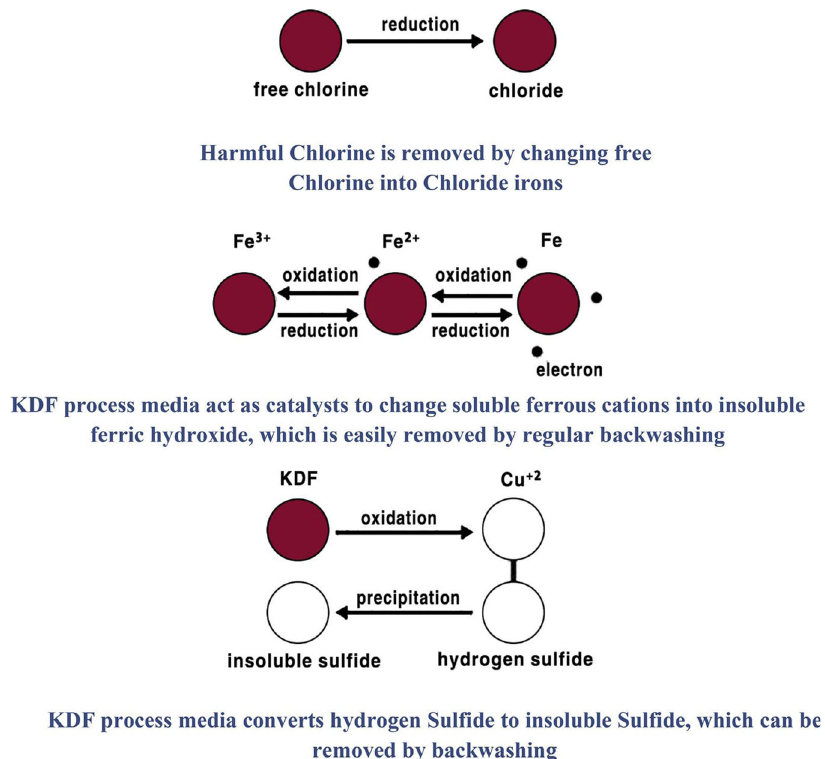
Fig. 6 Removal mechanism of KDF for chlorine, heavy metals, and hydrogen sul fi de. Heavy metals dissolved in the water are reduced into an insoluble form and thus precipitate out so they can be retained in the fi lter medium (reprinted with permission from 180 ; Copyright © Elsevier,